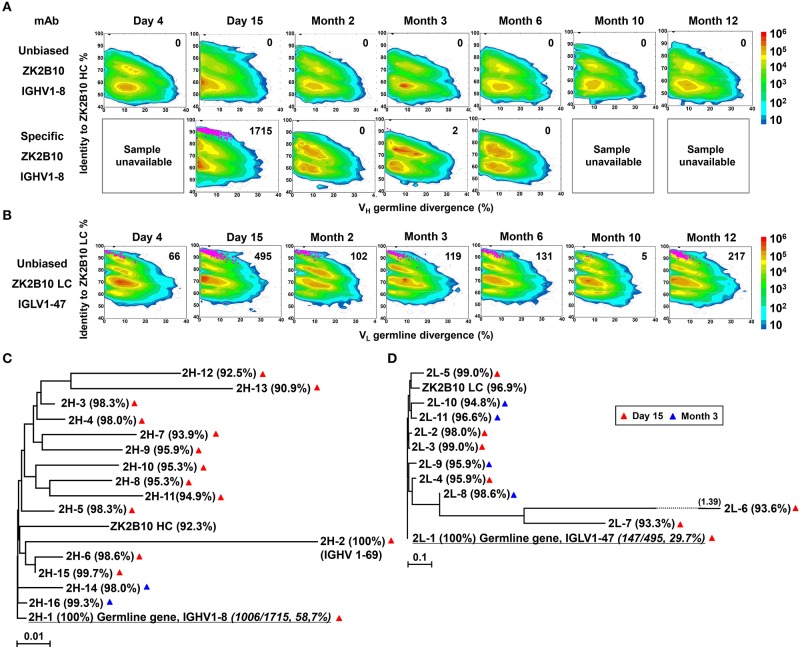
Lineage tracing of ZK2B10 in the Pt1 repertoire across ZIKV infection. (A) Lineage tracing of ZK2B10 heavy chain in unbiased antibody repertoire (upper panel) and in ZK2B10 gene-specific antibody population (lower panel). For ZK2B10 gene-specific sequence analysis, the PBMCs samples at Day 4, Month 10 and Month 12 were unavailable, which are marked as sample unavailable. (B) Lineage tracing of ZK2B10 λ chain in unbiased antibody repertoire. For each time point, the repertoire is shown as a two-dimensional (2D) plot, with the X-axis indicating the germline divergence of NGS-derived antibody sequences and the Y-axis for their identity with respect to ZK2B10 heavy or λ chain. Color coding indicates the sequence density on the 2D plots ranging from 101 to 108. ZK2B10 heavy and λ chains are shown as black dots on the 2D plots. CDR3-defined somatic variants that are evolutionarily related to ZK2B10 heavy and λ chain are shown as magenta dots, with the total number of reads labeled on the 2D plots (HC: heavy chain; LC: λ chain). (C,D) Neighbor-joining tree (MEGA6.0) depicting the relationship between the germline gene and representative ZK2B10 heavy (C) and λ (D) chain variants. Individual variants are labeled at the end nodes of each tree branch, alongside with their germline identity. Branch lengths are drawn to scale so that the genetic distance between different nucleotide sequences can be assessed. Color-coding of triangle indicates their emerging time during infection.